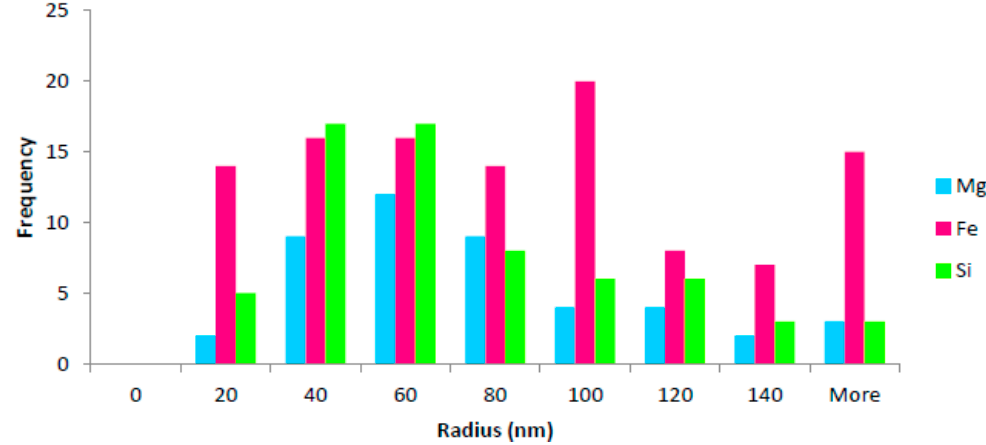
Figure 8. The subfigure labeled “HAADF” presents a HAADF-STEM micrograph affiliated with two larger polycrystalline boundary regions for an as-atomized Al 6061 powder particle. The col-